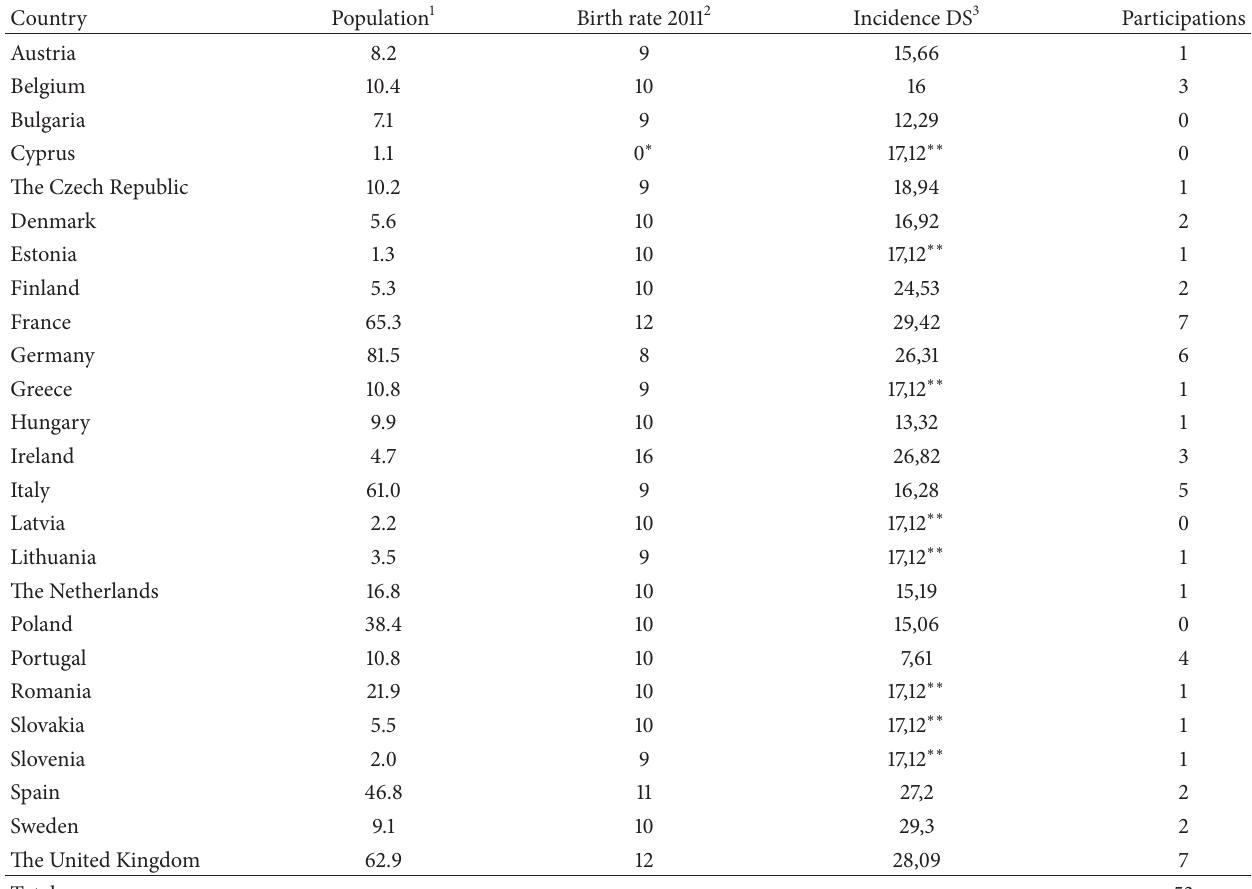
Table 1: Number of pediatricians needed in the European